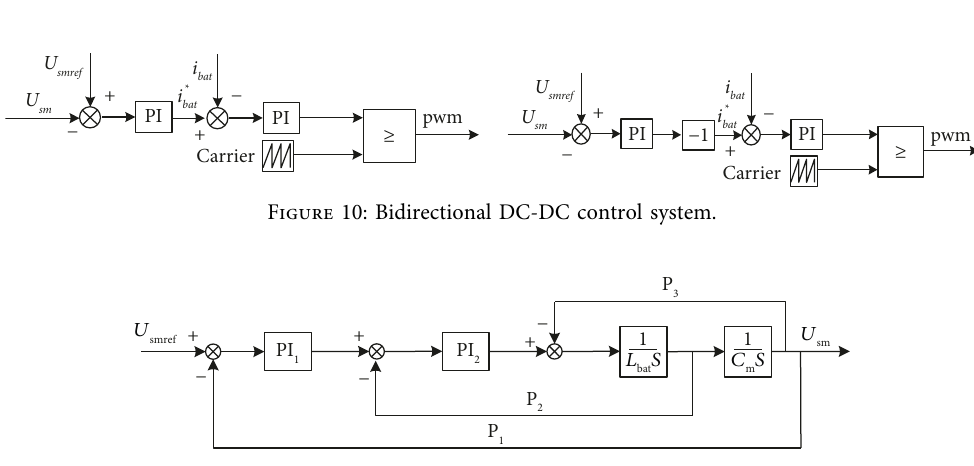
Figure 11: Transfer function structure of the bidirectional DC-DC double closed-loop control system.